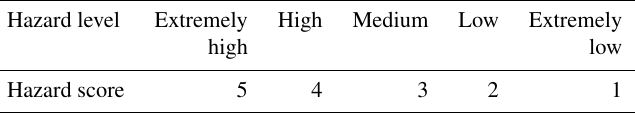
Table 9. Grades of exposed objects (modified from Lin, 2013).